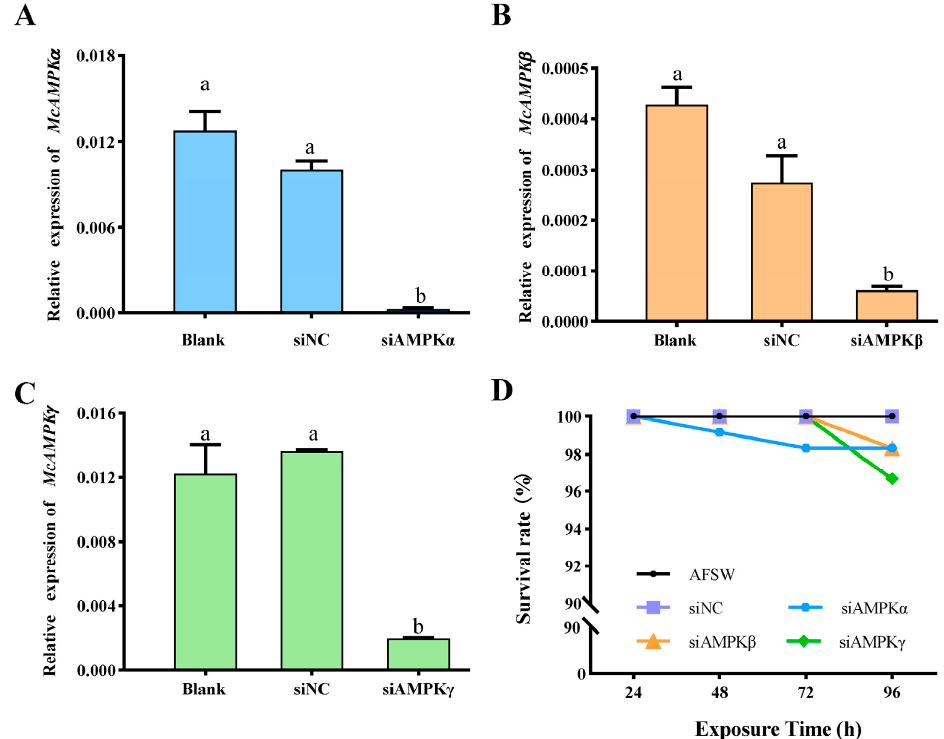
Figure 11. The effects of RNAi on the relative expression of McAMPK genes and the survival rate of M. coruscus . ( A ) McAMPK α expression in electroporated with si AMPK α and control larvae, ( B ) McAMPK β expression in electroporated with si AMPK β and control larvae, ( C ) McAMPK γ expres- sion in electroporated with si AMPK γ and control larvae and ( D ) The survival rate of different groups electroporated with si AMPK α , si AMPK β and si AMPK γ , respectively.